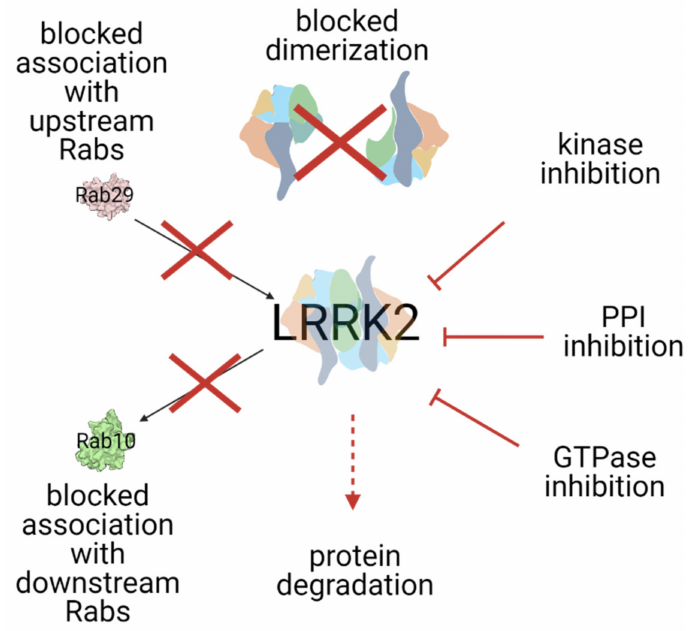
Figure 3. Summarized LRRK2 targeting strategies. See the text for a detailed explanation of each